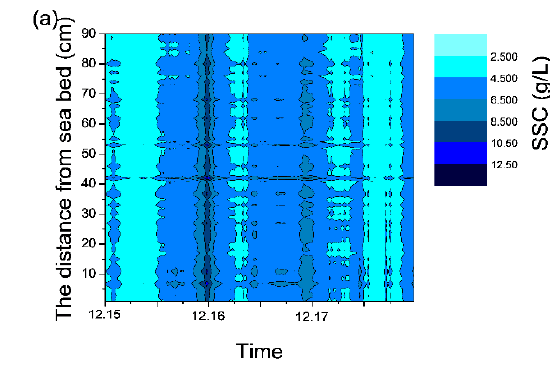
Table 1. Physical and mechanical properties of seabed soils collected in a 5 m sediment core.